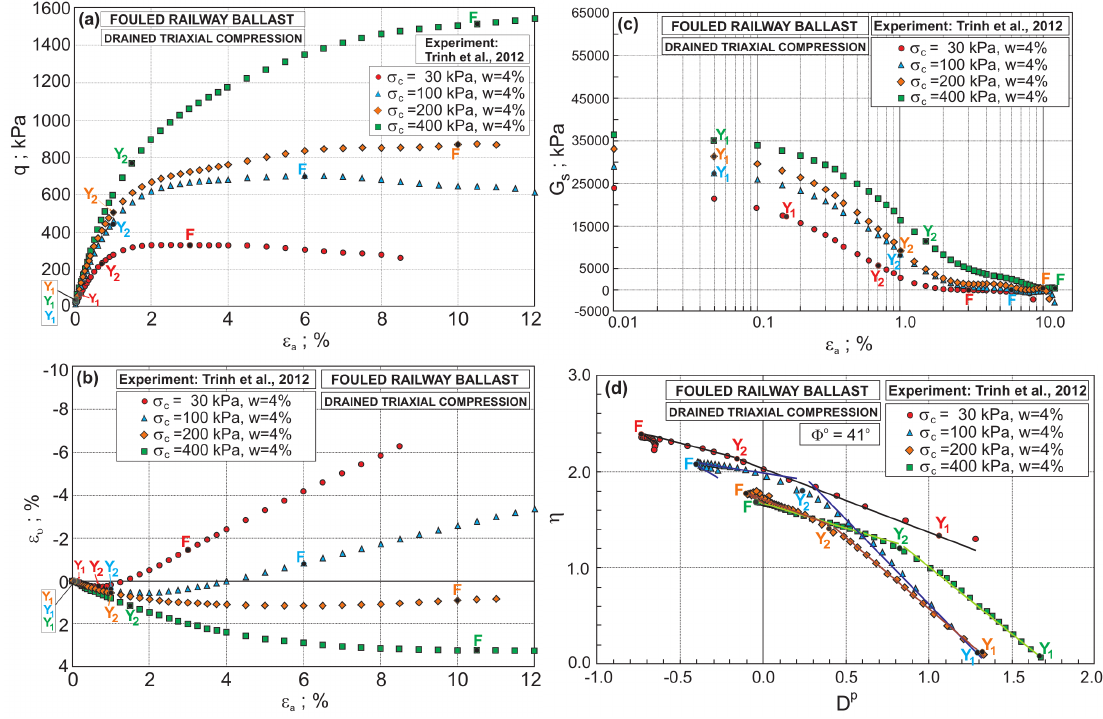
Figure 4 : Relationships for fouled ballast at 4% water content: (a) q – e